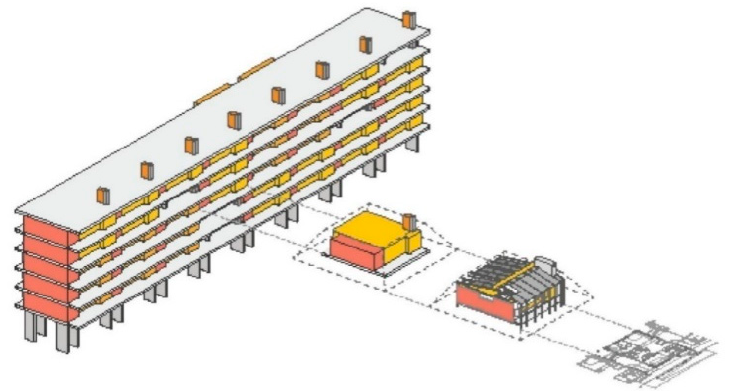
Figure 8. Decantation process from the collective building to the prototype in the Solar City.